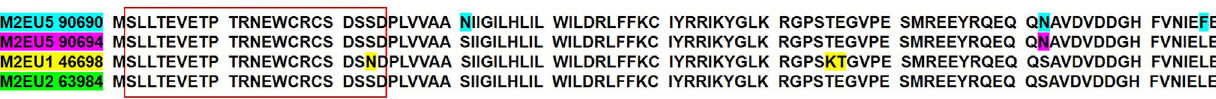
FigUre 1 | avian and human influenza a h5n1 virus M2e sequences retrieved from genBank and aligned using clustal X . EU590690 turkey, EU590684 houbara bustard, EU263984 human, and EU146698 human. The 23 amino acid ectodomain is indicated by the red square. Differences in the amino acid sequence are indicated in different